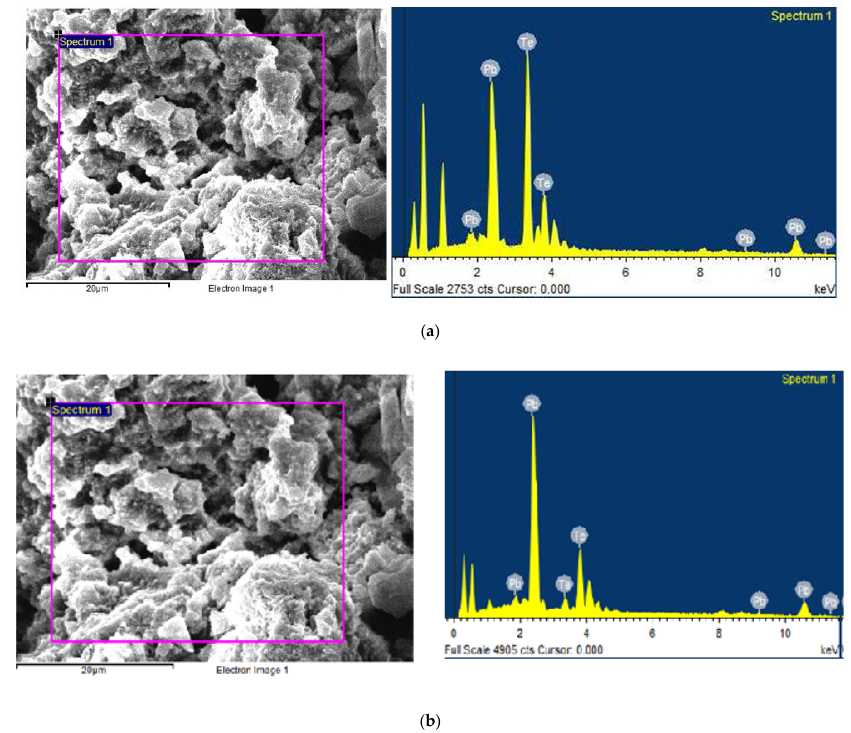
Figure 8. Energy dispersive spectroscopy (EDS) and corresponding scanning electron microscopy (SEM) of two samples. From up to down: ( a ) A1; ( b ) A5.